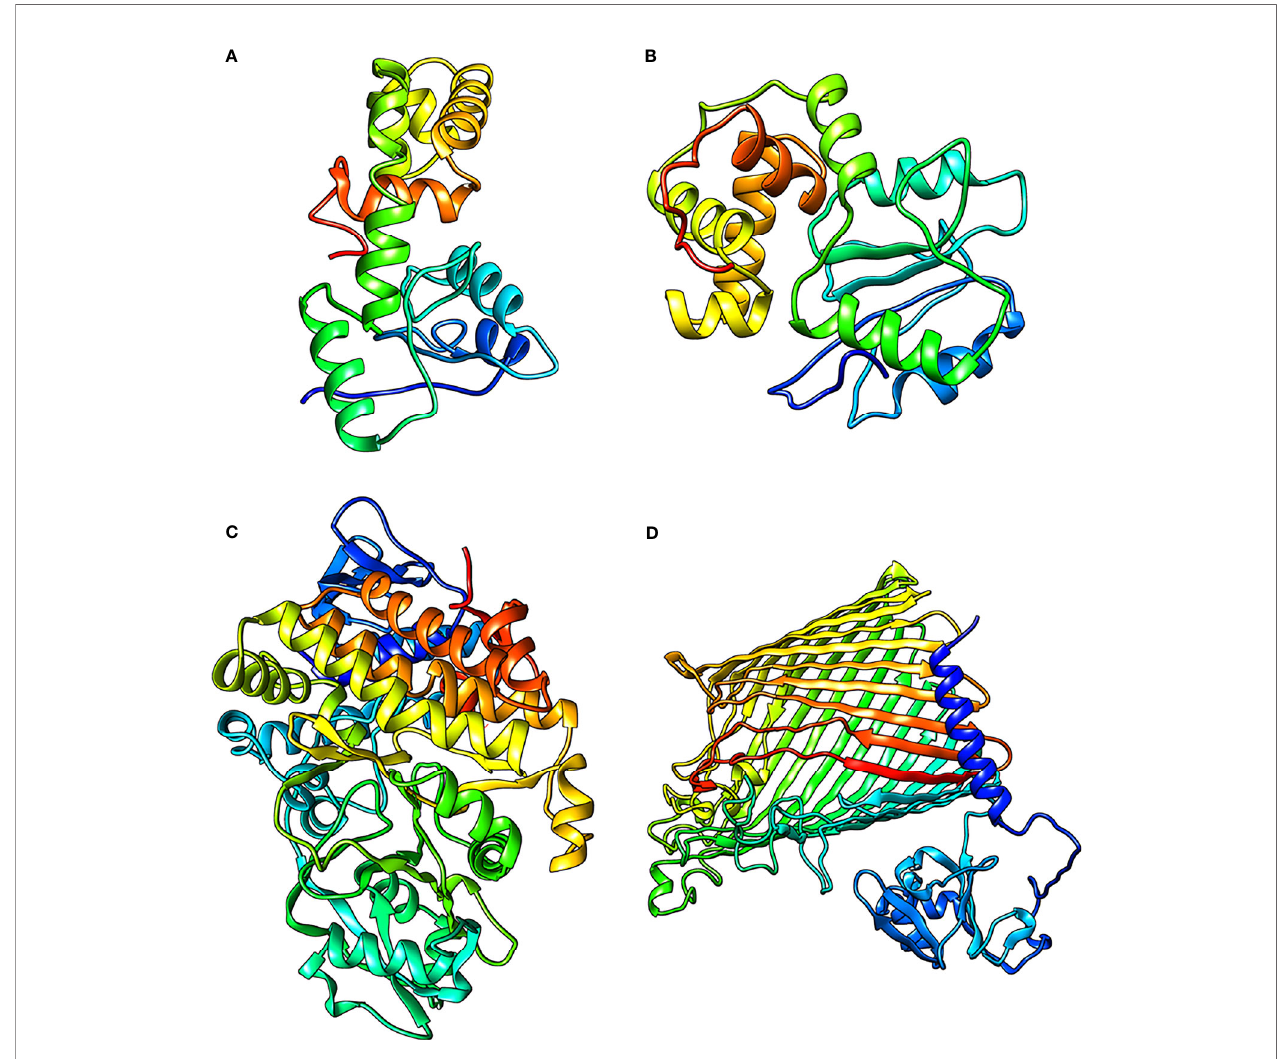
FIGURE 4 | The re fi ned structures of the proteins (A) RmpA (B) RmpA2 (C) IucA and (D)